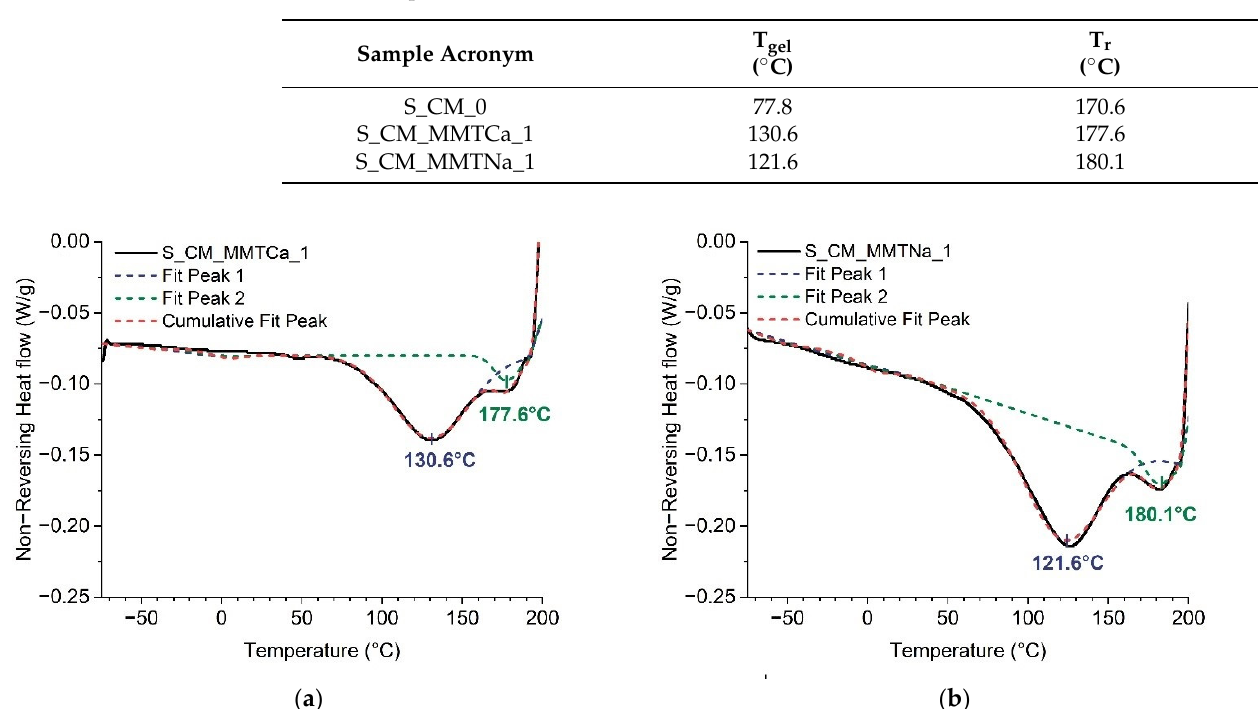
Figure 1. MDSC thermograms of non-reversing transition with curve deconvolution of starch films with 1% of ( a ) calcium montmorillonite, ( b ) sodium montmorillonite.